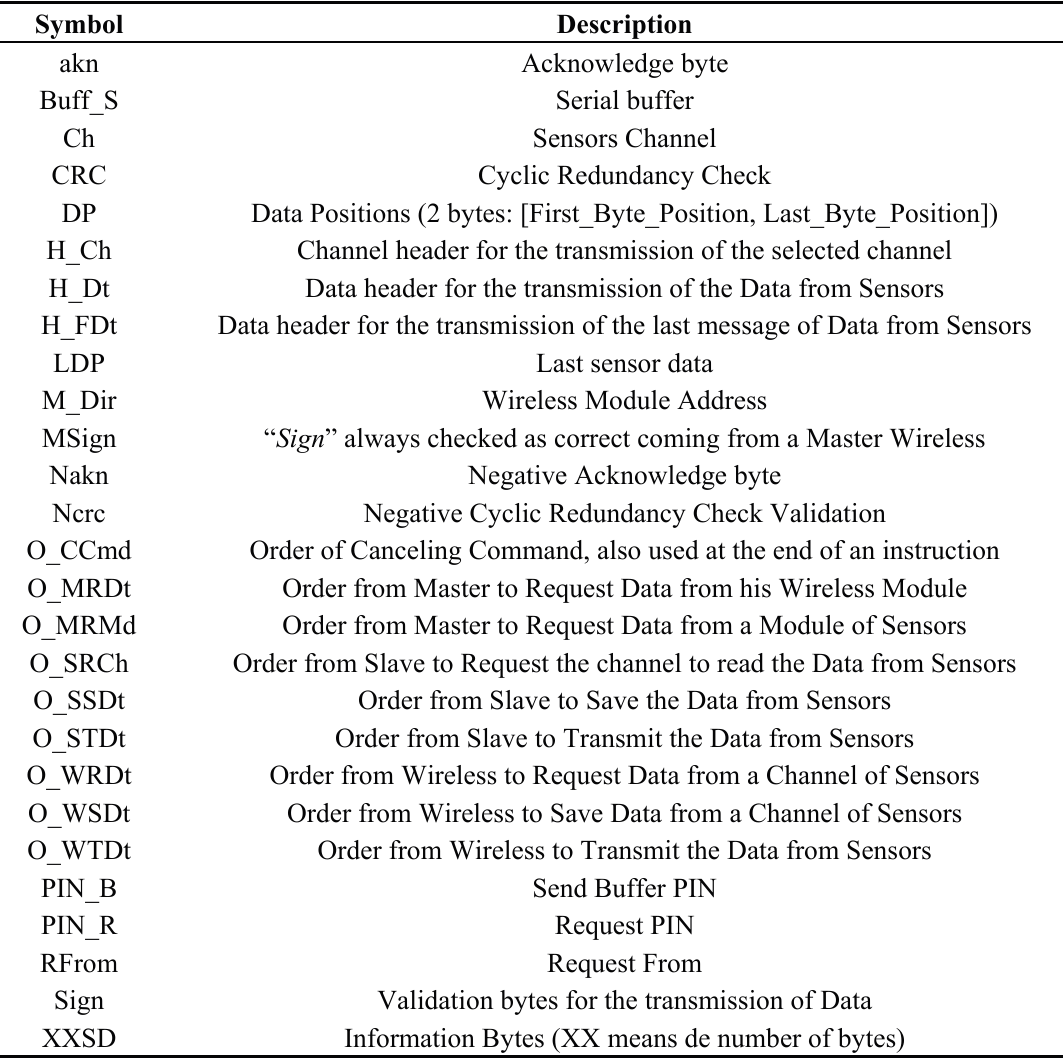
Table 1. Glossary of Symbolism